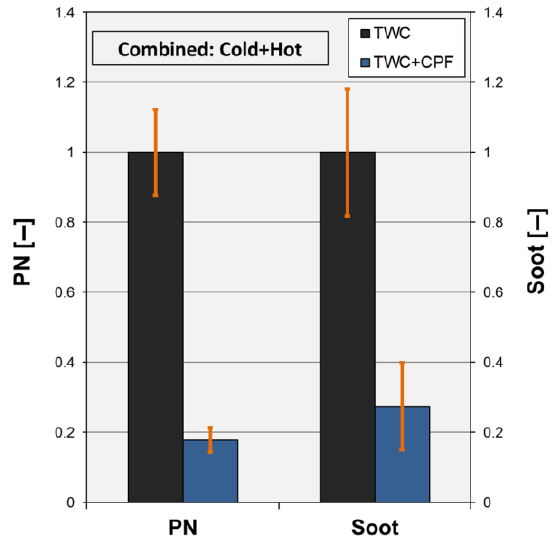
Figure 6. Combined dimensionless mean PN and Soot values collected in the “TWC” and “TWC + CPF” configurations and their corresponding standard deviations (orange vertical